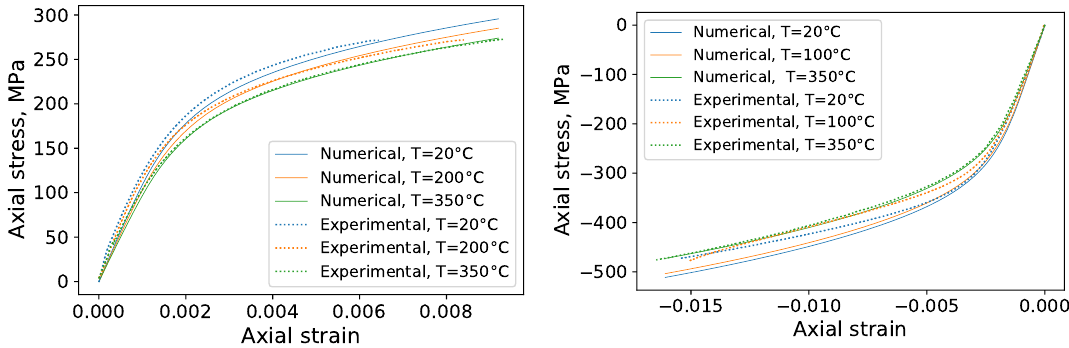
Figure 12. Comparison of numerical and experimental stress–strain curves in tension ( left ) and compression ( right ) for different temperatures.